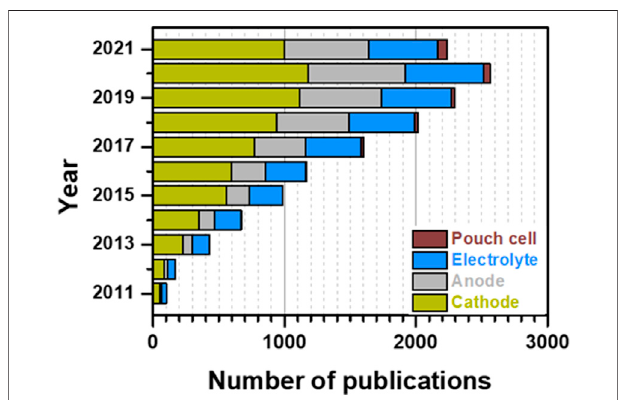
FIGURE 1 | Publication trend (from 2011 to 2021) of Li-S research reported in the literature. Data were obtained from the Web of Science in December 2021. NOTE: Literature survey was performed according to each de fi ned topic. Since most publications cover several given subjects, the